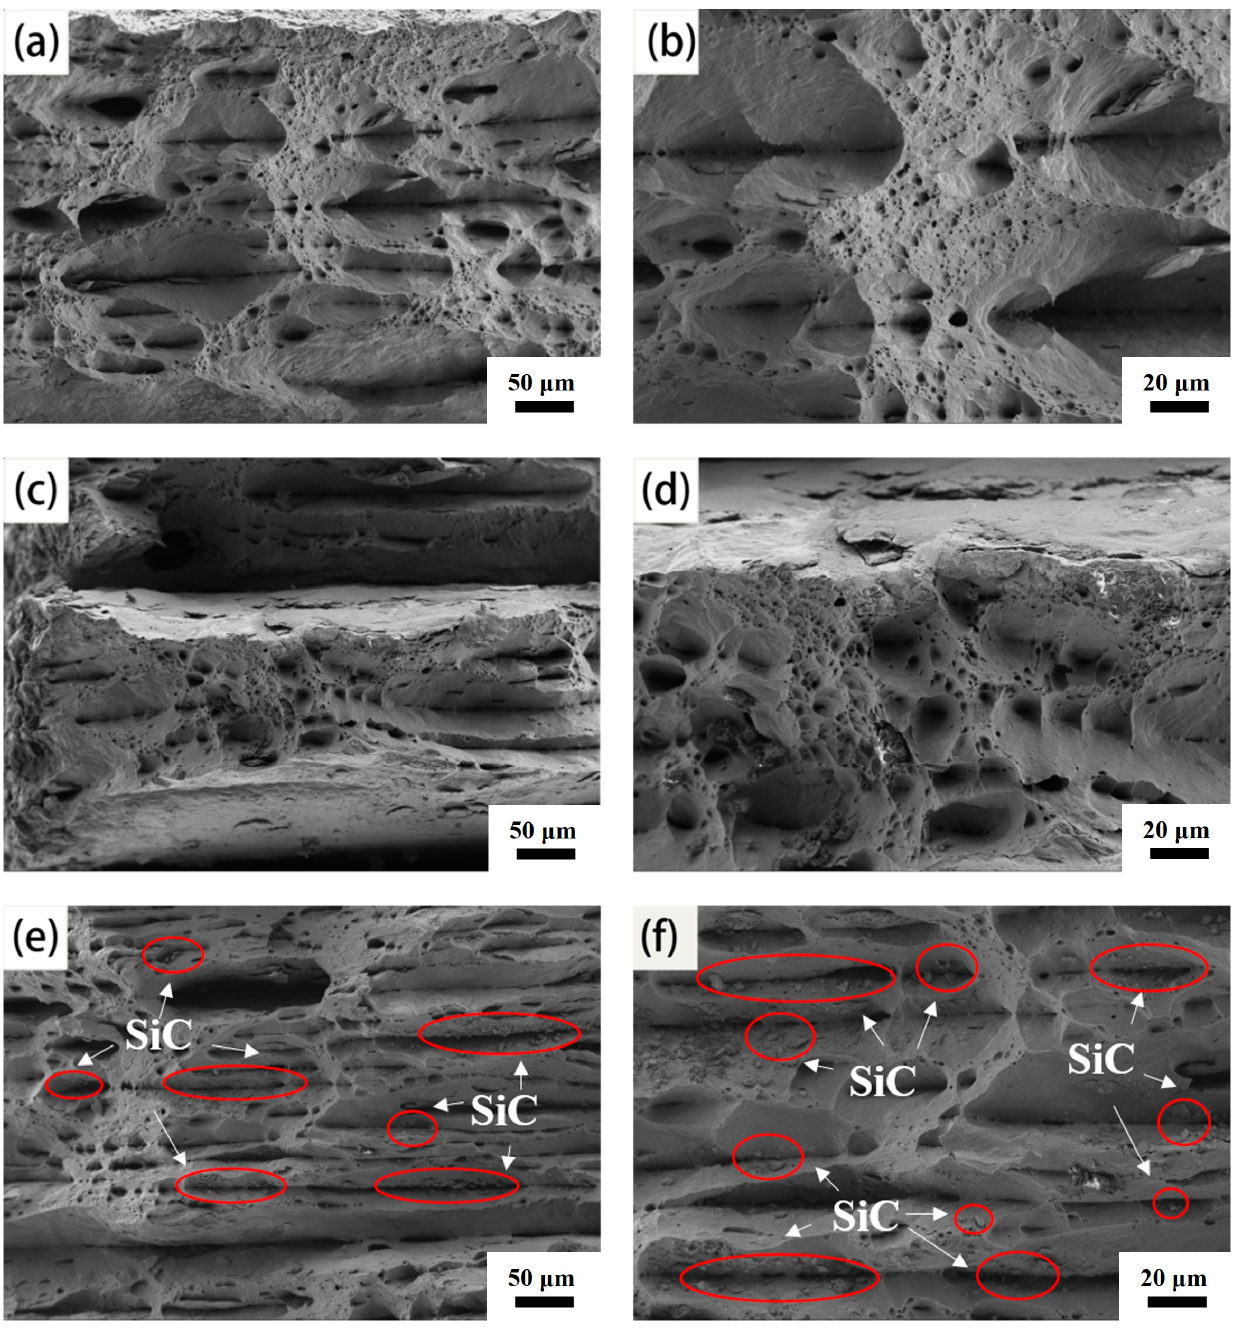
Figure 11. SEM micrographs of the fracture surfaces for the ( a , b ) M1, ( c , d ) M2, and ( e , f ) M3 samples after three MARB